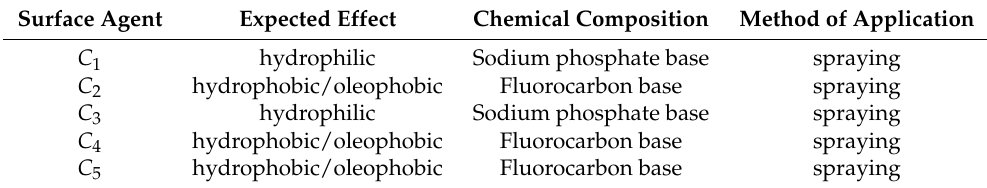
Table 1. Commercial textile surface agents and their expected effects.